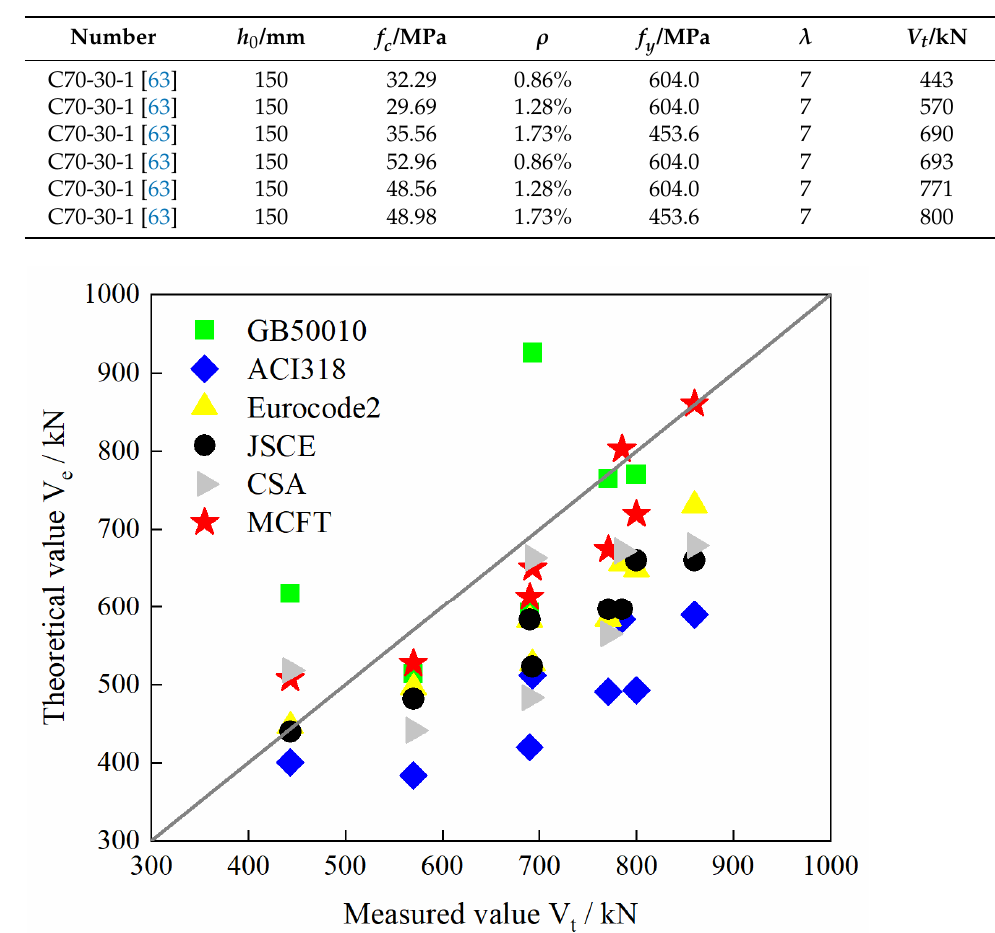
Table 5. Specimens parameters.